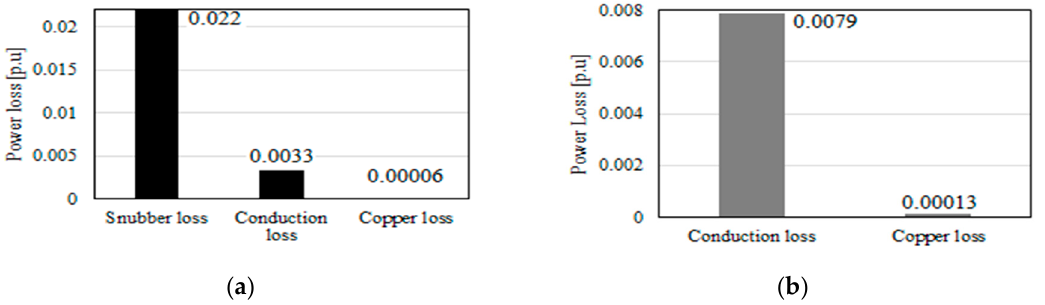
Figure 13. Output power versus power loss of the 3P-BIDC in continuous mode and intermittent mode during light-load condition with Yy transformer configuration.